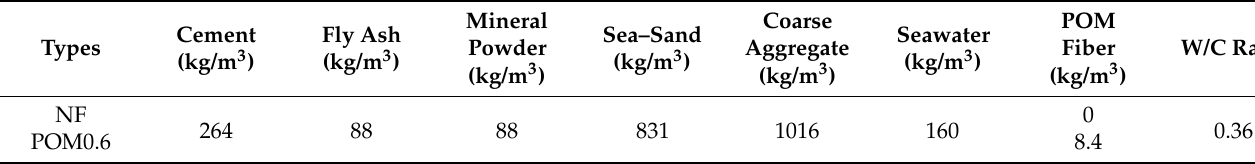
Table 3. Proportions of NF and POM0.6 mixtures.